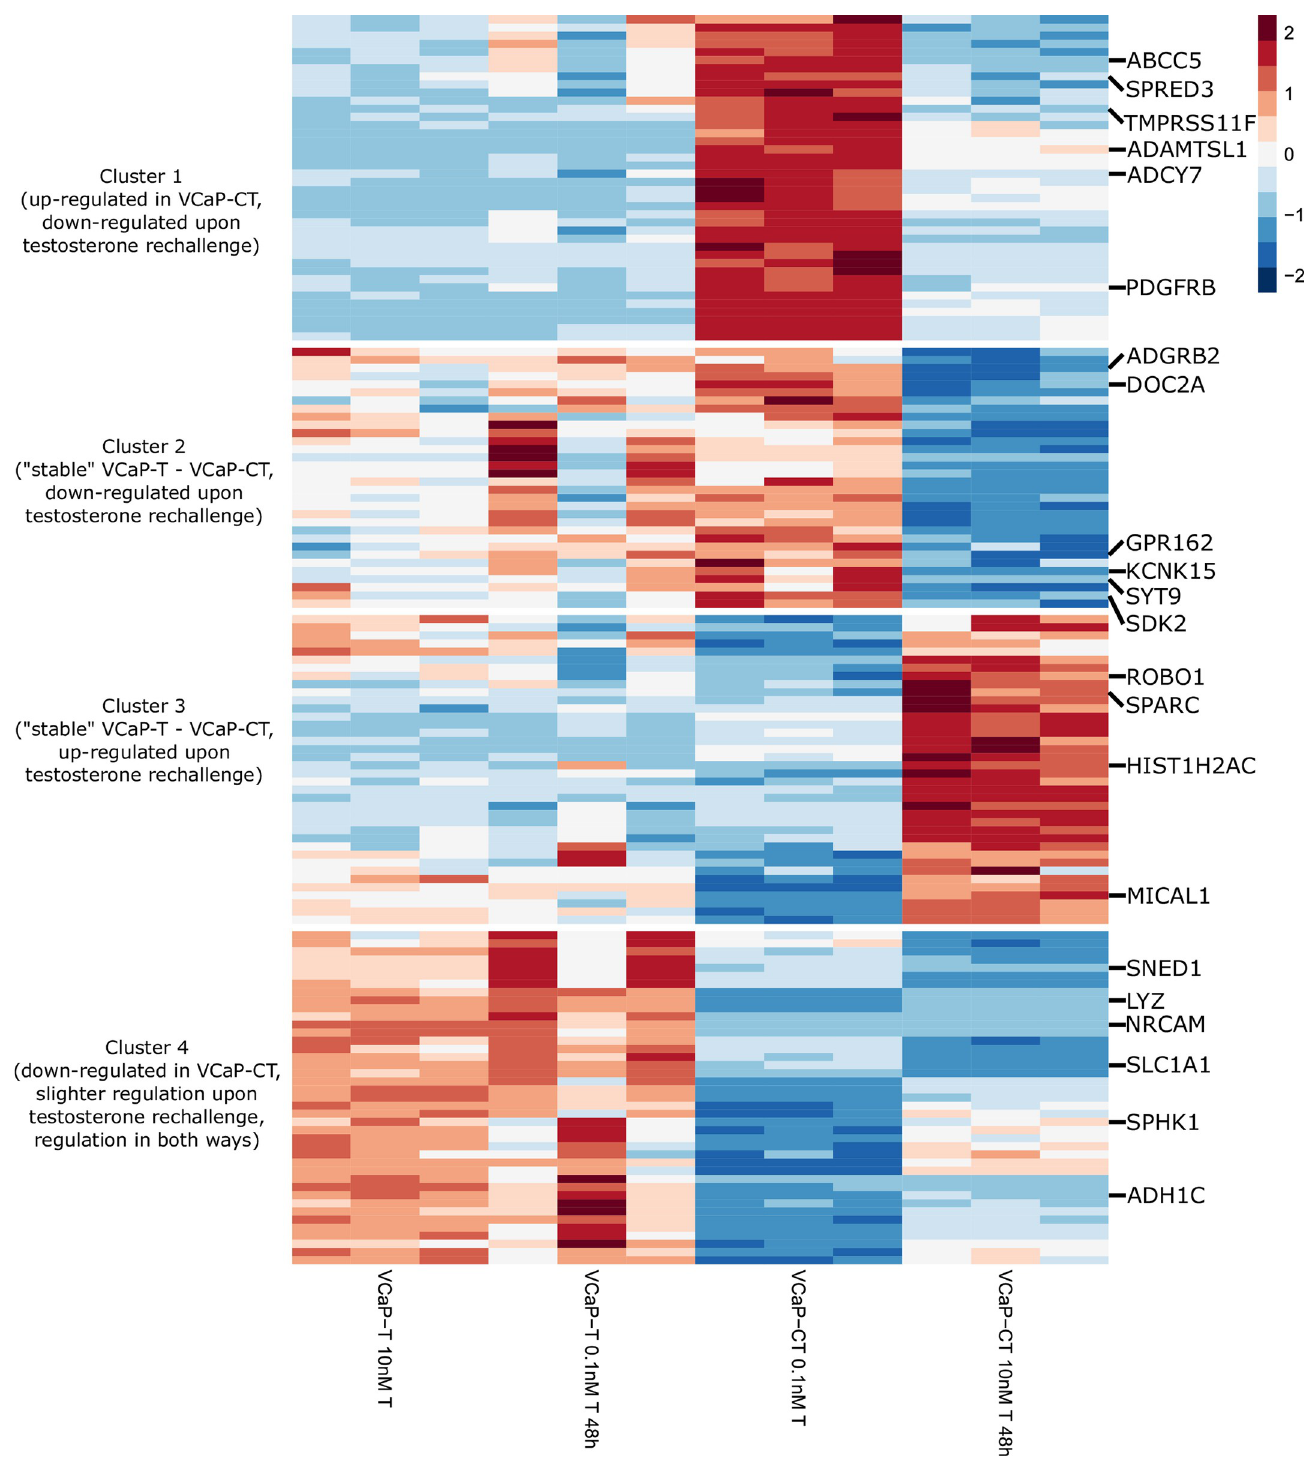
Fig 6. Non-AR-associated genes gaining AR-association in VCaP-CT. Heatmap of 151 non-AR-associated genes that gained AR-association in VCaP-CT and their expression levels in VCaP-T and VCaP-CT cell lines upon testosterone level changes. Expression levels are scaled and centered by row. Using hierarchal clustering with Euclidean distances genes were clustered into 4 clusters with different characteristics. Genes with association to progression-free survival are pointed.